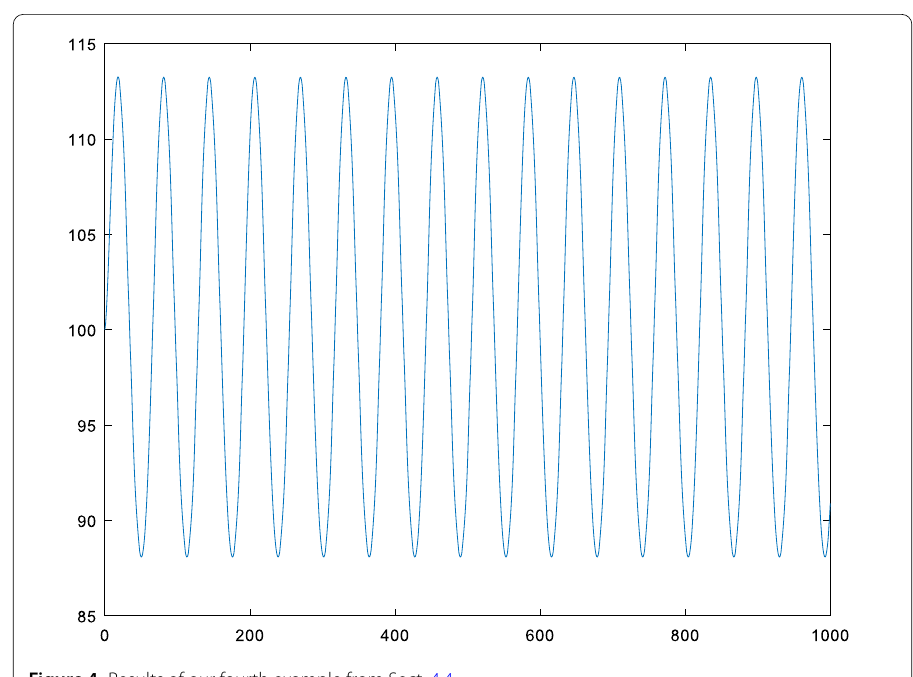
Figure 4 Results of our fourth example from Sect.